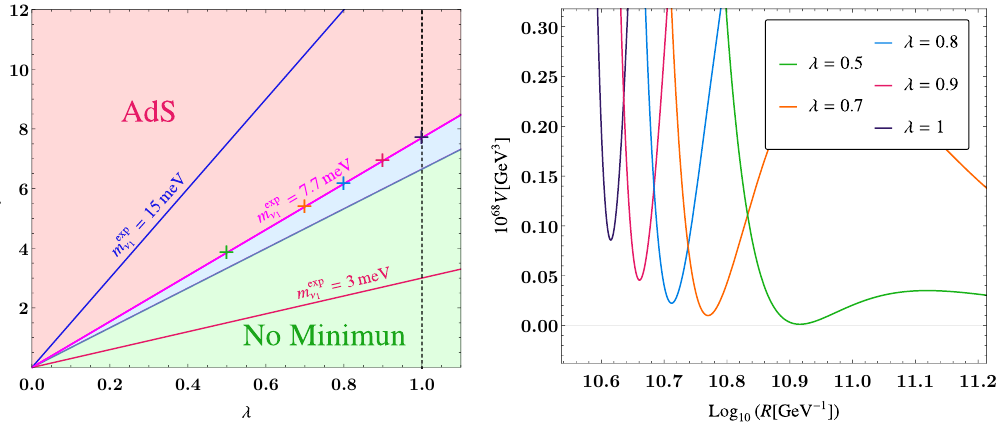
Figure 5 . Left: lightest neutrino mass versus the scanning parameter λ for Dirac neutrinos. The cosmological constant changes as Λ ( λ ) = Λ ( λ = 1) λ α , where α = 4 . Straight lines never cross 4 d 4 d from the AdS to the runaway area so there is no violation of the AdC. Right: in this figure we show how the potential changes along the scanning for the particular value m exp = 7 . 7 meV. We find that ν a tower must become light in the limit λ → 0 . This tower is the KK tower. Coloured crosses in the left hand side correspond to the coloured curves in the plot on the right hand